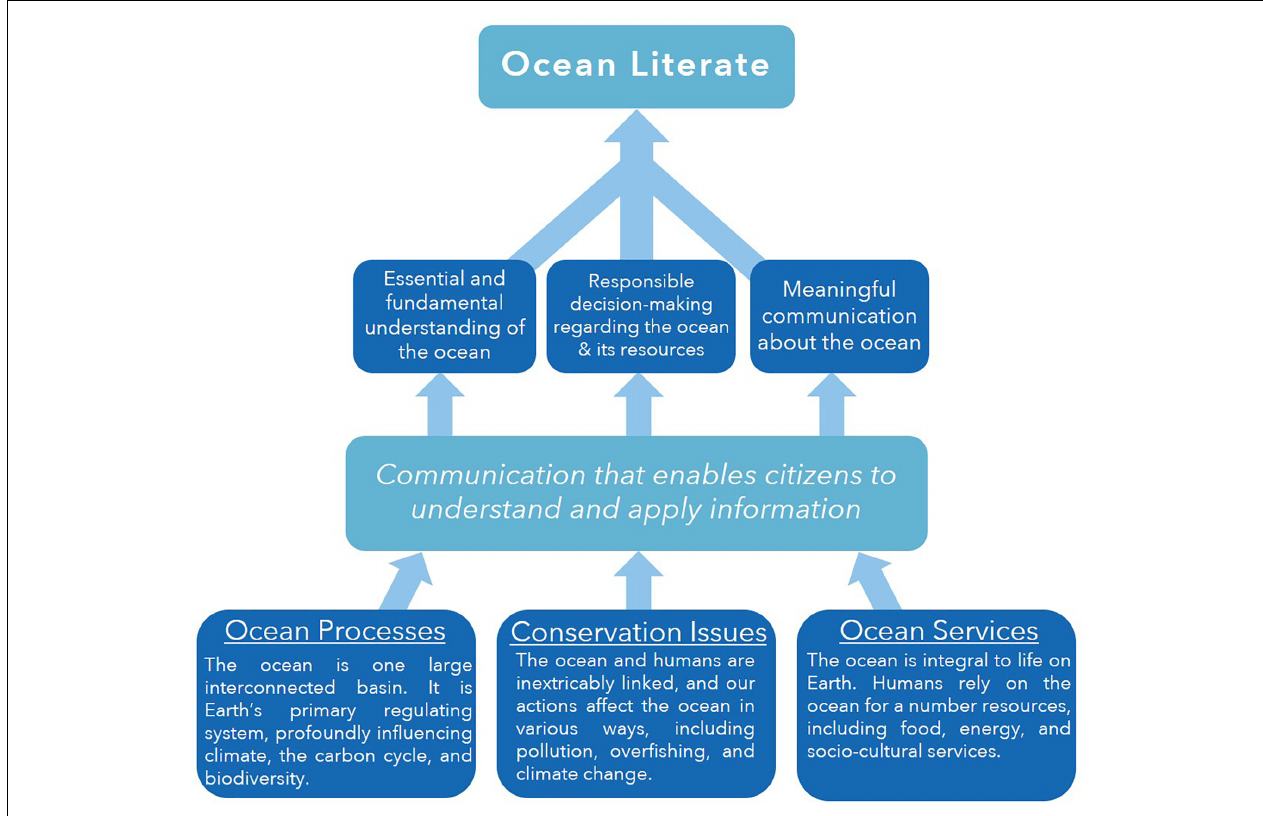
FIGURE 1 | Ocean Literacy Development Framework. The schematic demonstrates the three themes used to identify an ocean literacy post – Ocean Processes, Conservation Issues, and Ocean Services – and highlights the three key principles that define an ocean literate person. Altogether, Figure 1 represents a conceptual framework by which marine science communication results in an ocean literate person (Schoedinger et al.,